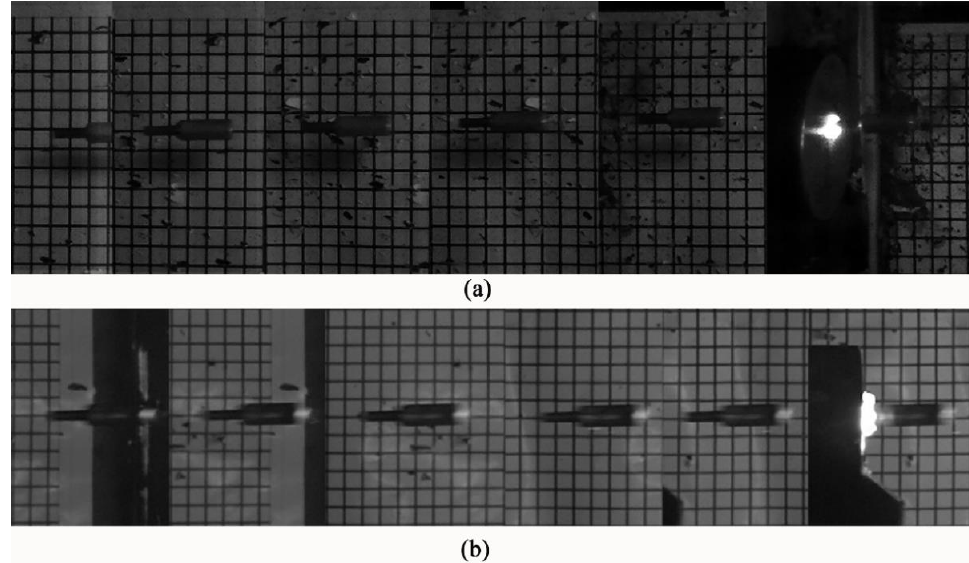
Figure 13. Projectile flight process and landing attitude: ( a ) FeNiCoCr HEA annealed at 600 °C, 1152 m/s and ( b ) FeNiCoCr HEA annealed at 850 °C, 1108 m/s.